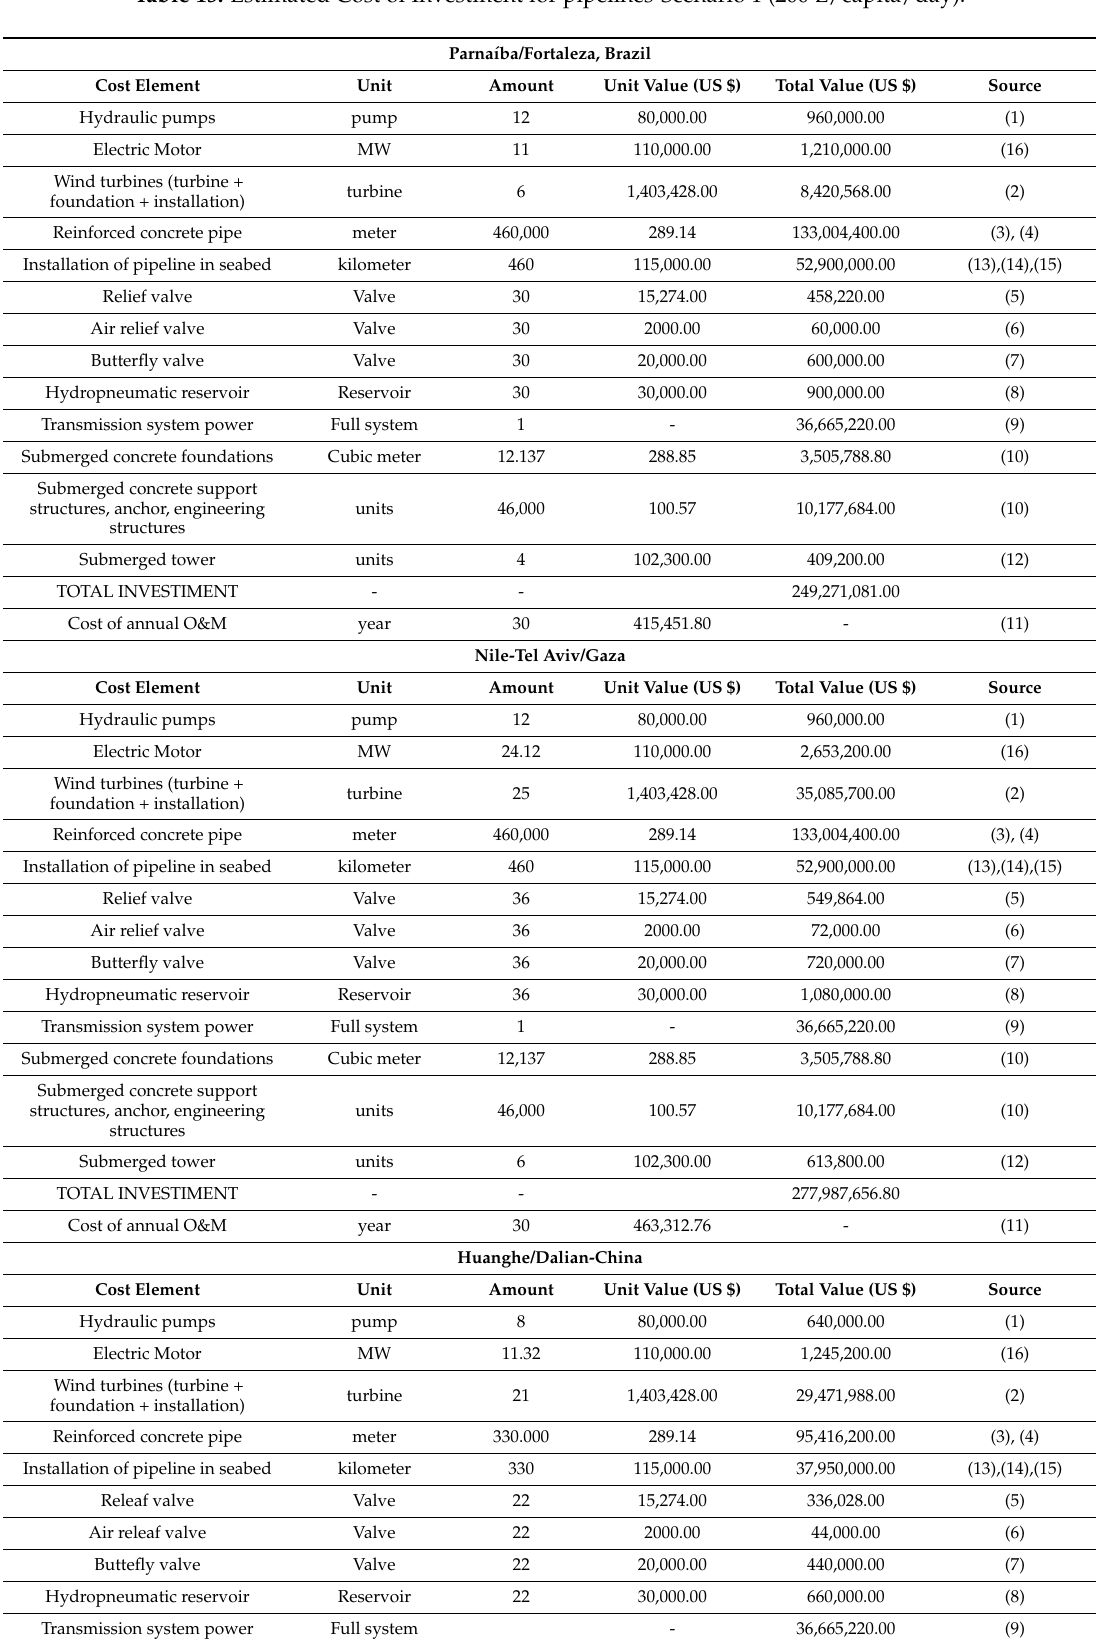
Table 15. Estimated Cost of Investment for pipelines-Scenario 1 (200